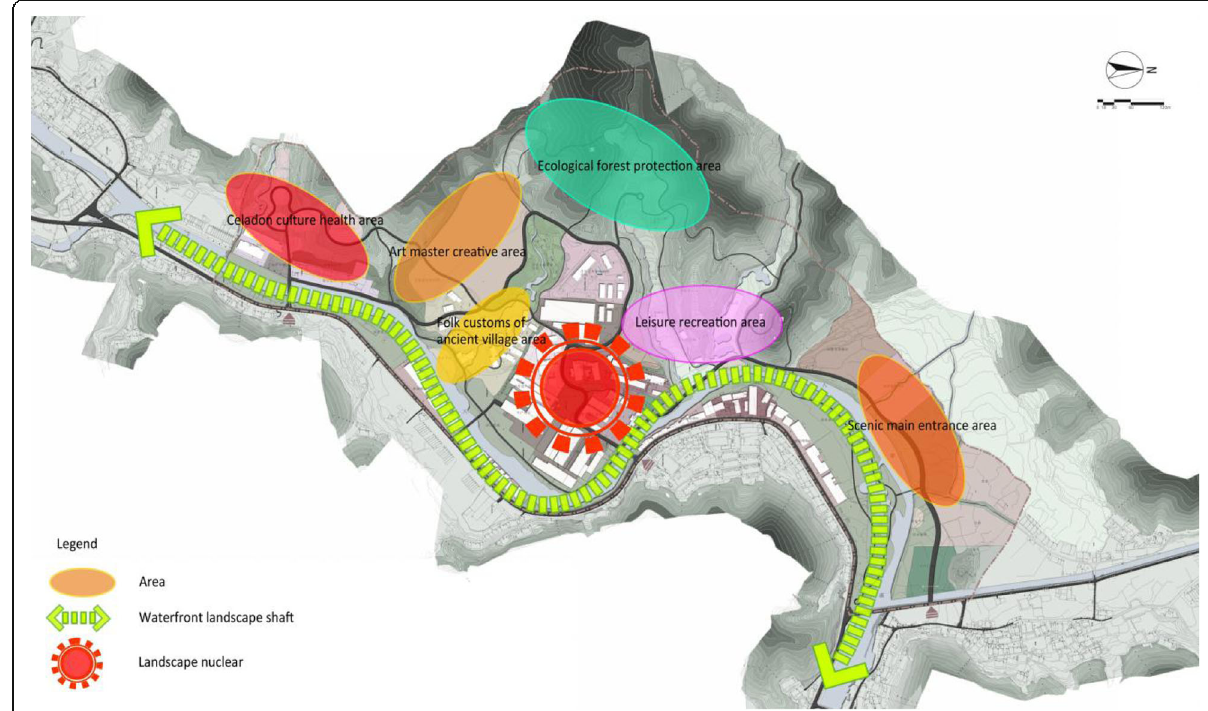
Fig. 4 The planning structure of Longquan celadon cultural industrial